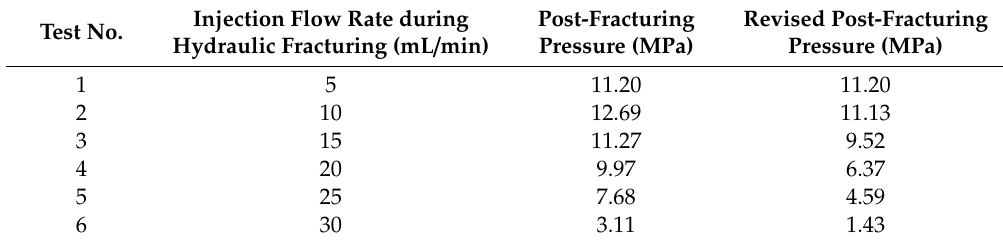
Table 4. The revised post-fracturing